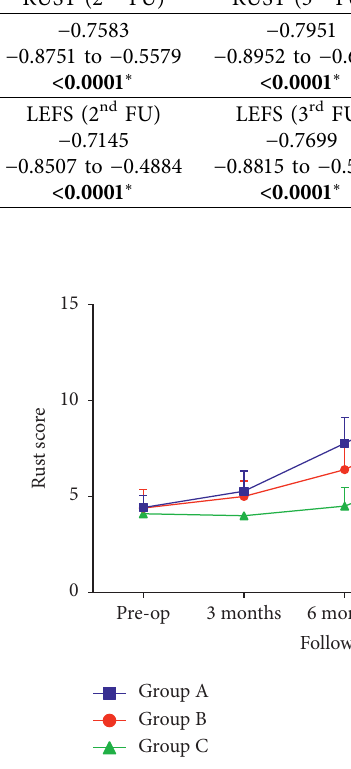
Table 7: Correlation analysis of NUSS versus RUST and LEFS at various follow-ups. NUSS vs.